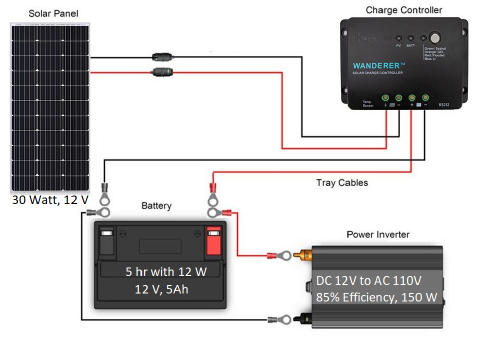
Figure 7. Main components for a small solar power system